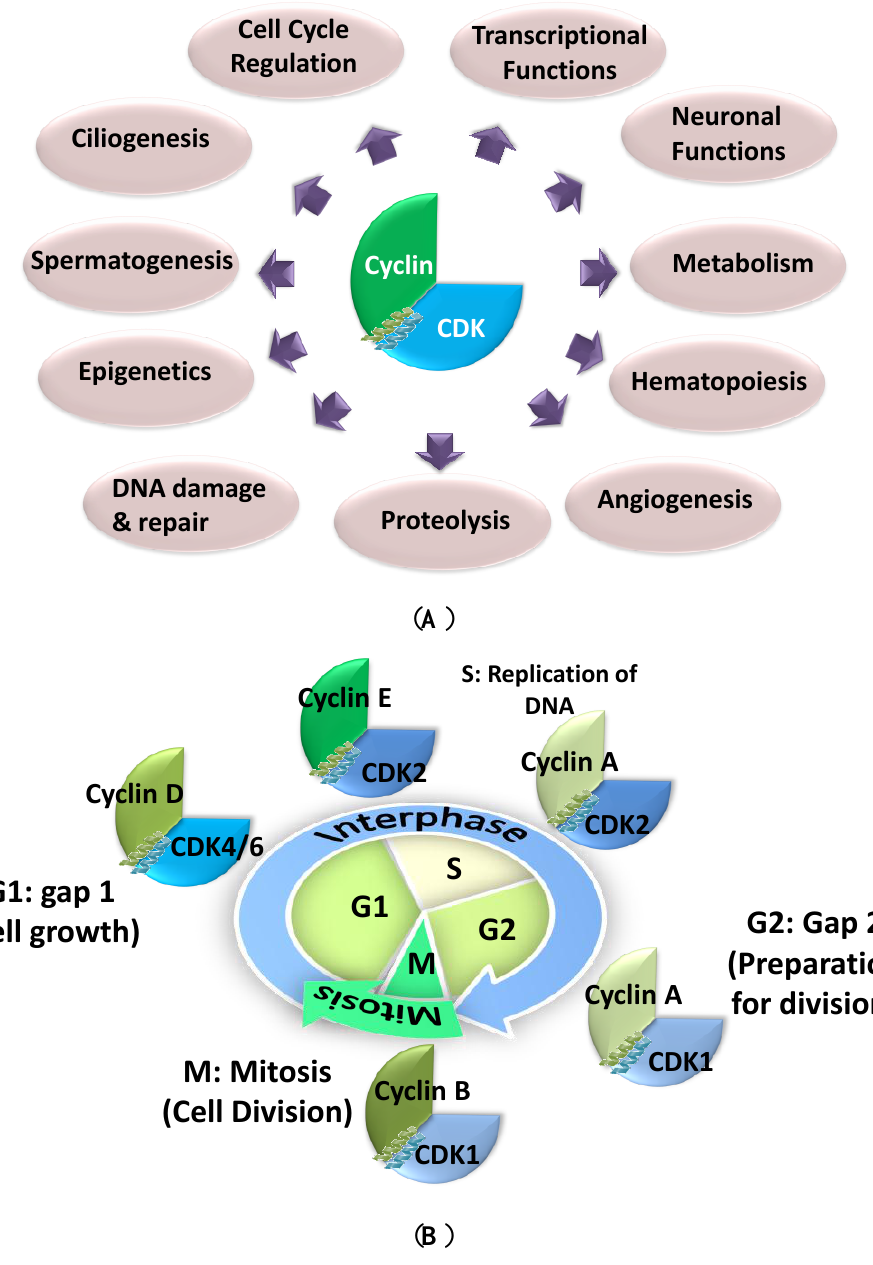
Figure 1. Functional Diversity of Cyclin-dependent Kinases. ( A ) Schematic representation of the functional diversity of Cyclin-dependent kinases; ( B ) Cell cycle regulation by CDK/cyclins: CDK1/cyclin B during the mitosis, CDK4 and 6/cyclin D for progression through G1 phase, CDK2/cyclin E for G1/S transition, CDK2/cyclin A at the S phase and CDK1/cyclin A for progression through G2